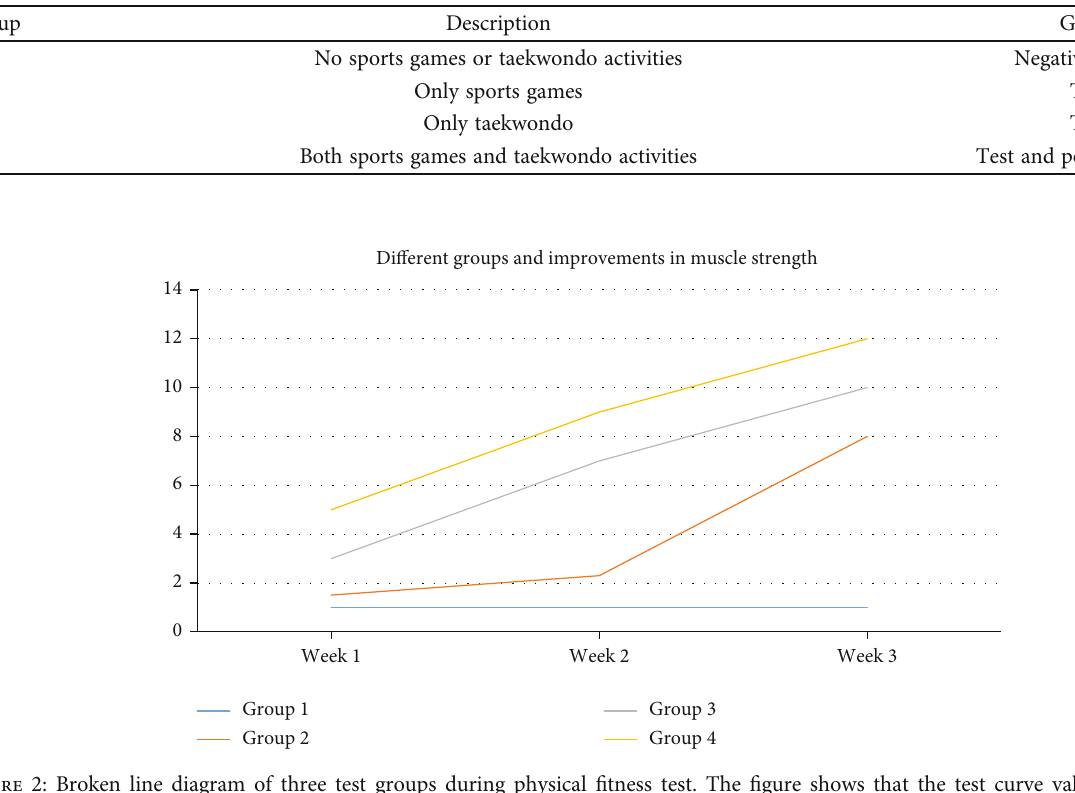
Table 2: Various divisions of the respondents in the study.